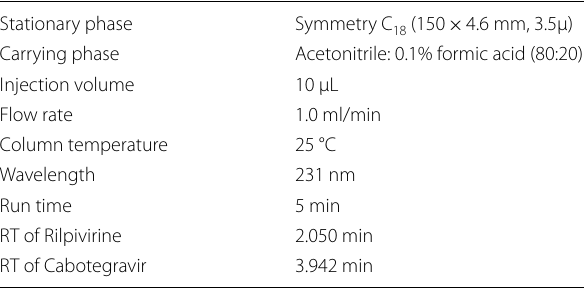
Table 1 Optimized chromatographic conditions Stationary phase